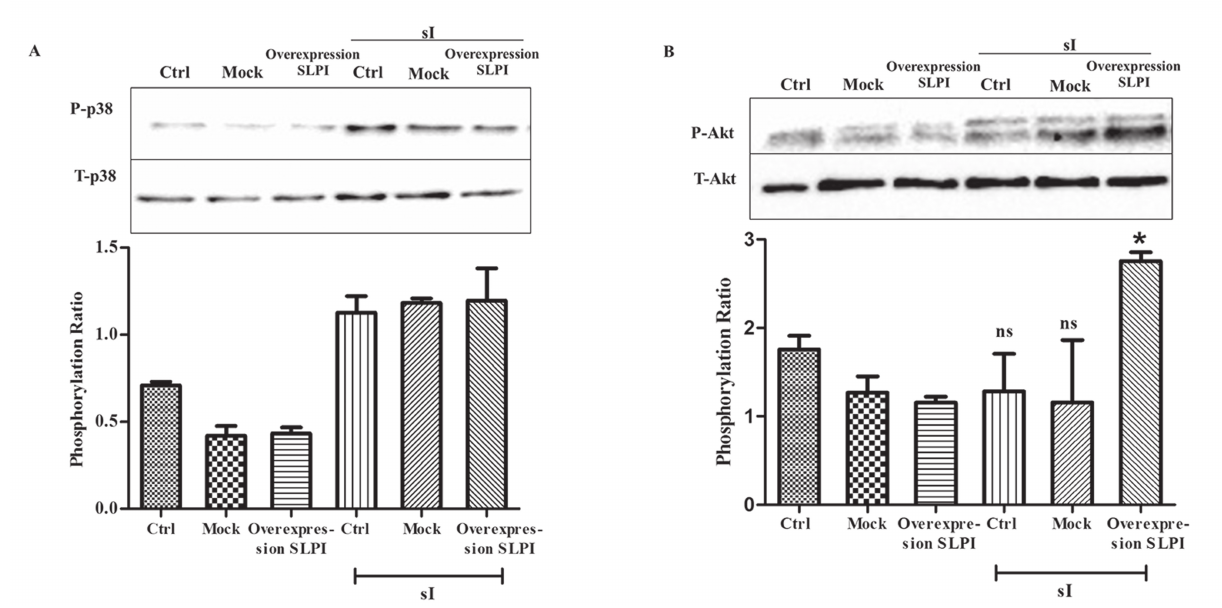
Figure 4: Effects of the overexpression of rhSLPI in H9c2 cells on p38 MAPK and Akt activation during sI. The parental H9c2 cells, the mock transfected cell, and the stable H9c2 cell lines overexpressing rhSLPI, were subjected to sI. The cells were then harvested, and p38 MAPK (p-P38) and Akt (p-Akt) activation were assessed by Western Blot. (A) p38 MAPK activation; (B) Akt activation. Each bar graph represents fold phosphorylation of p38 MAPK and Akt for three experiments. * p < 0.05 vs control of each group